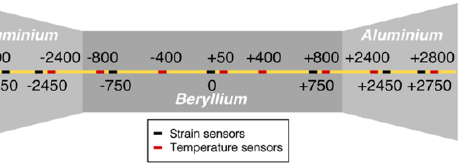
Figure 28. Thermal profile of the beam pipe relative to different operational status of the CMS Figure 28. Longitudinal layout of the fiber optic monitoring system installed on the CMS central BP. detector, occurring in 2018 (adapted from Ref. [130]). The quotes indicate the positions, relative to the center of the central BP of the FBG sensors. All the quotes refer to the FBG sensors of a single fiber, with respect to the center of the central BP. Four fibers have been installed in the cardinal position of the BP (adapted from Ref. [131]).